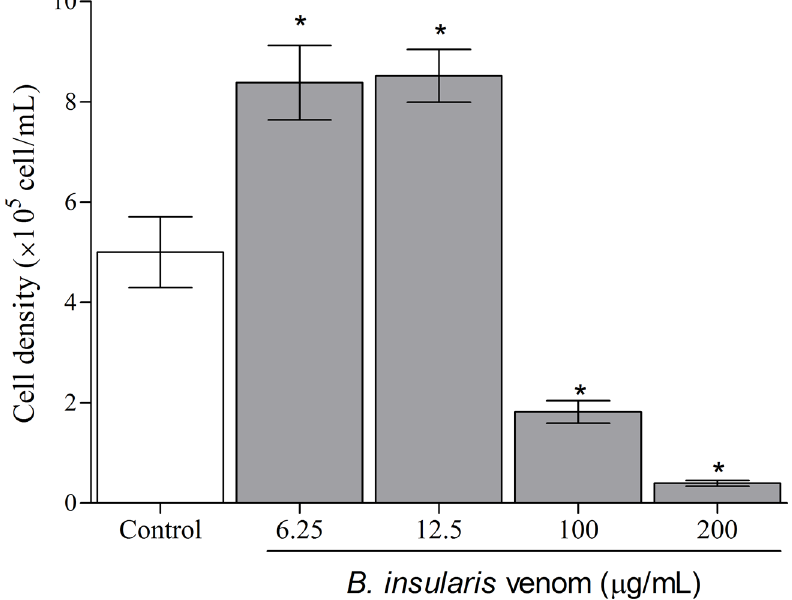
Fig 3. Cell number in machophages treated with BiV. The cell density was determined by counting in Neubauer chamber. * p < 0.05 vs. negative control group.